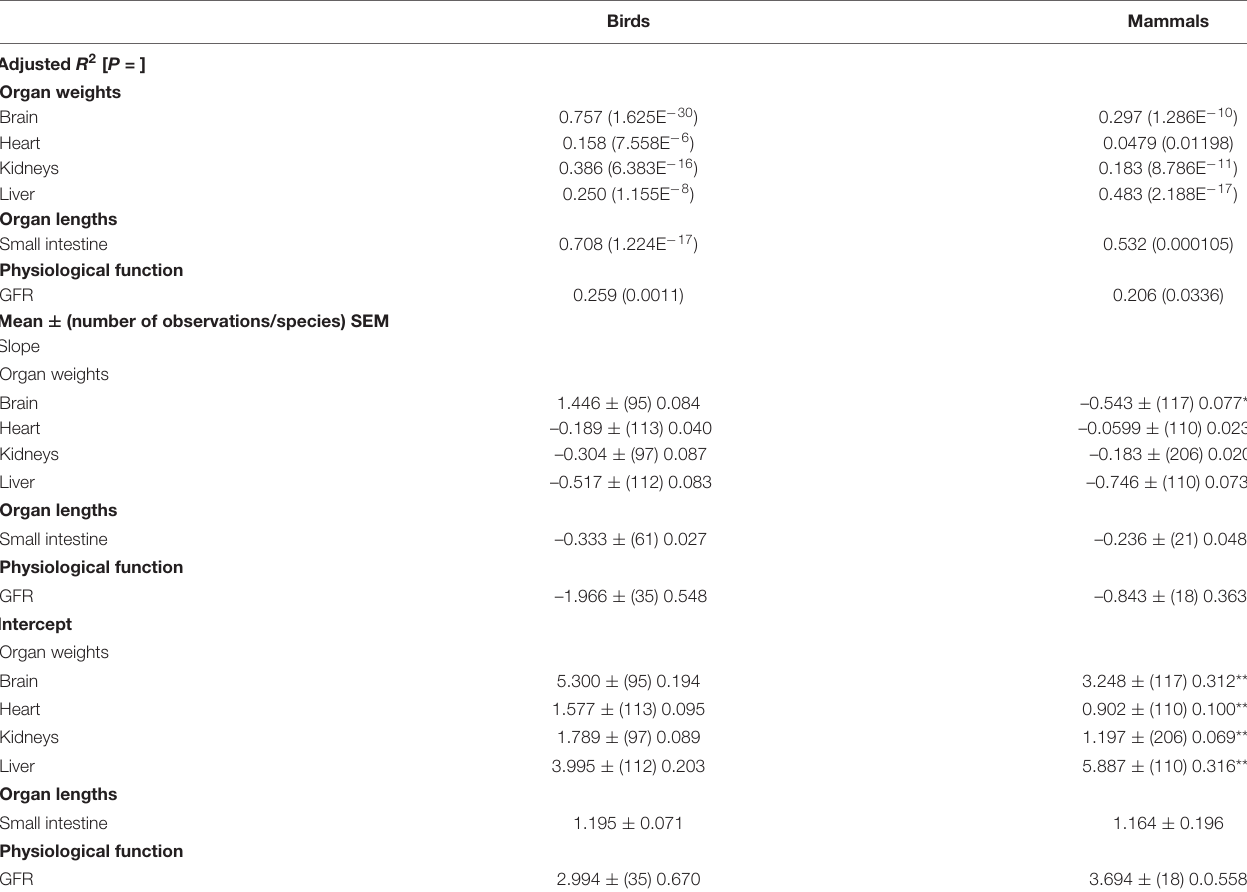
TABLE 5 | Relationships between relative weights of organs (as % of body weight), relative lengths of the small intestine (cm g − 1 ) and organ functions (per kg body weight) versus log 10 body weight (g) [for data from individual species see Supplementary Table 7 (mammals), 8 (birds)]. Birds